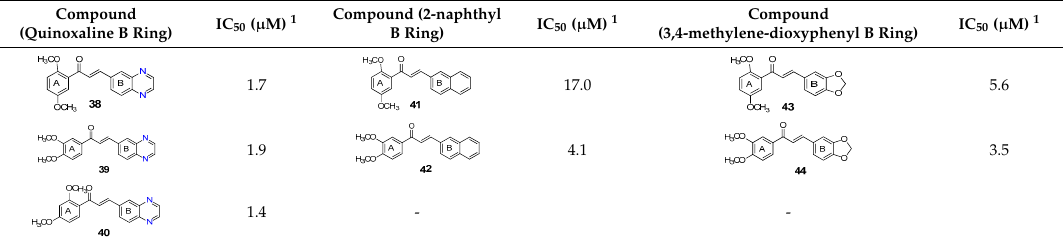
Table 2. BCRP inhibitory e ff ects of compounds 38 – 44 in HEK293-ABCG2 cells. Table 2. BCRP inhibitory effects of compounds 38 – 44 in HEK293-ABCG2 cells. Table 2. BCRP inhibitory effects of compounds 38 – 44 in HEK293-ABCG2 cells. Table 2. BCRP inhibitory effects of compounds 38 – 44 in HEK293-ABCG2 cells. Table 2. BCRP inhibitory effects of compounds 38 – 44 in HEK293-ABCG2 cells. Table 2. BCRP inhibitory effects of compounds 38 – 44 in HEK293-ABCG2 cells. Table 2. BCRP inhibitory effects of compounds 38 – 44 in HEK293-ABCG2 cells. Table 2. BCRP inhibitory effects of compounds 38 – 44 in HEK293-ABCG2 cells. Compound Compound (Quinoxaline B Ring) IC (Quinoxaline B Ring) Compound (Quinoxaline B Ring) IC 50 (µM) 1 50 (µM)